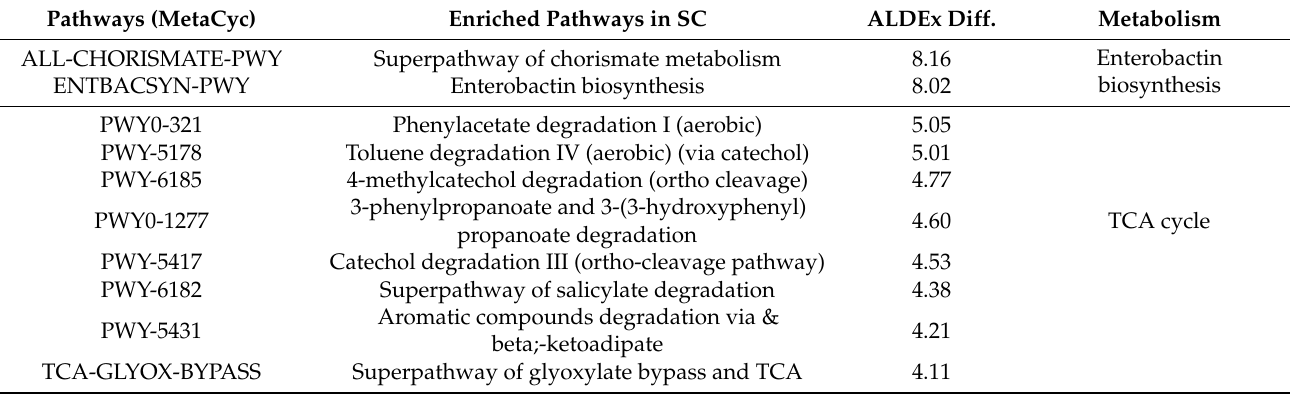
Table 1. Enriched metabolic pathways in the SC compared to the